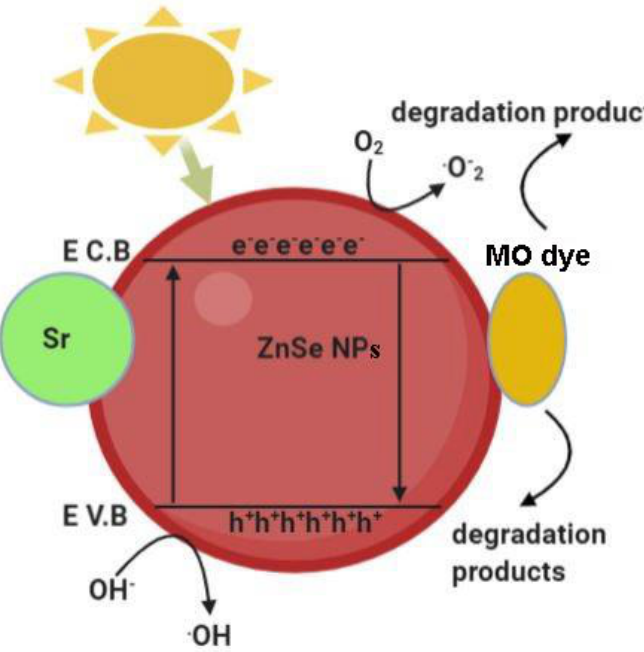
Figure 12. Photocatalytic dye degradation mechanism of the Sr-doped ZnSe nanoparticles.